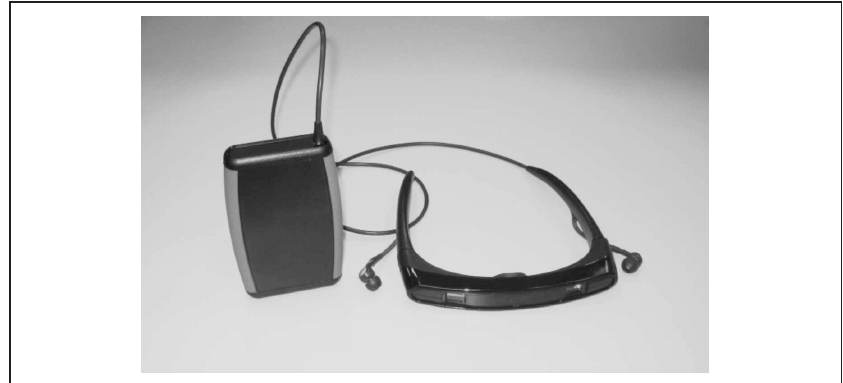
FIGURE 1 | Virtual reality goggles used in this study, containinga built-in LCD screen between the visors which projects floor tiles when subjects are moving, and earphones sounding a step-matched cue as determined by the connected sensor, strapped at the